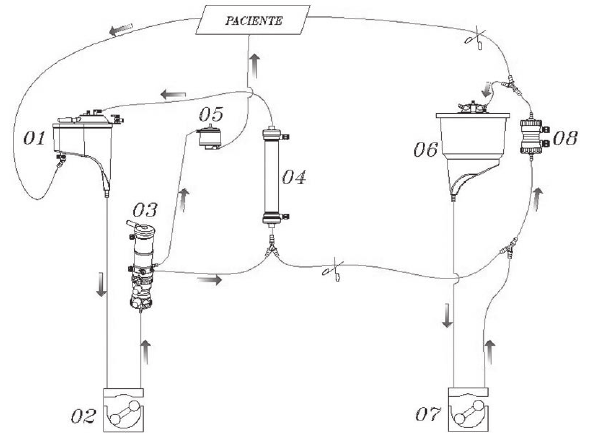
Fig. 1 - Desenho esquemático da ultrafiltração convencional (UFC) com uso do luer do oxigenador retornando sangue ao reservatório